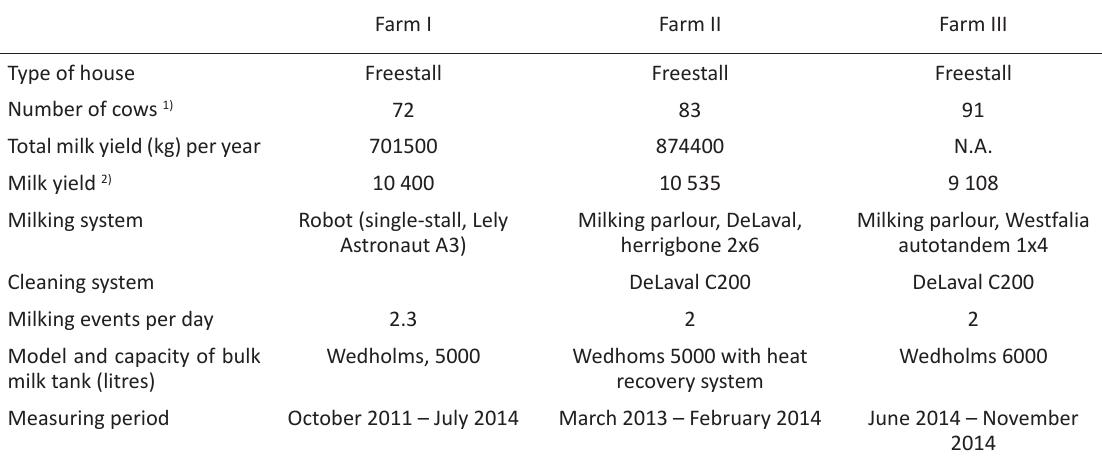
Table 1. Background information on the cow